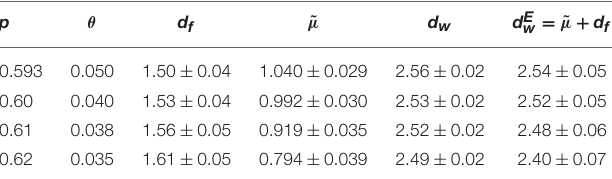
TABLE 2 | Exponents of θ -subnetworks minimizing C